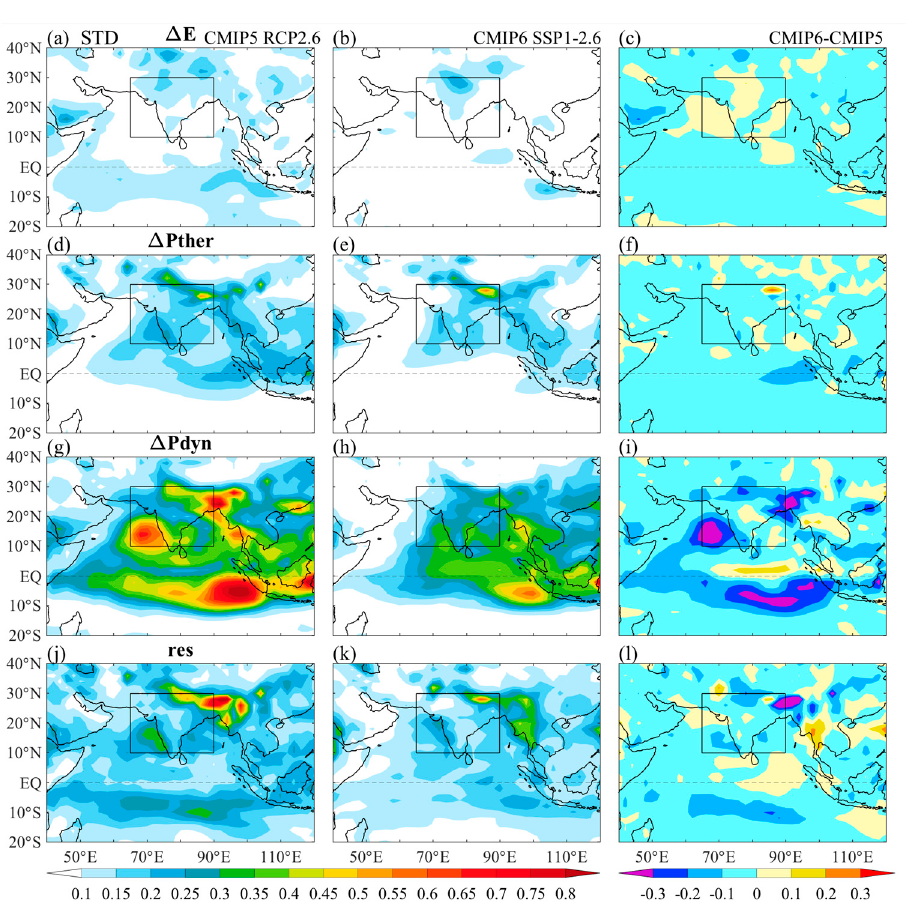
Figure 7. Intermodel standard deviation (STD, mm day − 1 ) for the subcomponents of precipitation change under ( a,d,g,j ) RCP2.6 and ( b,c,h,k ) SSP1-2.6 and ( c,f,i,l ) their differences.